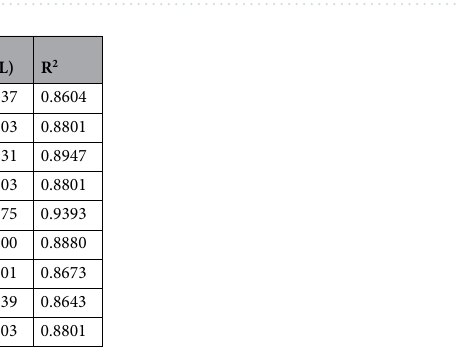
Table 5. Adam–Bohart model parameters for the adsorption of cadmium ions. Significant values are in bold.